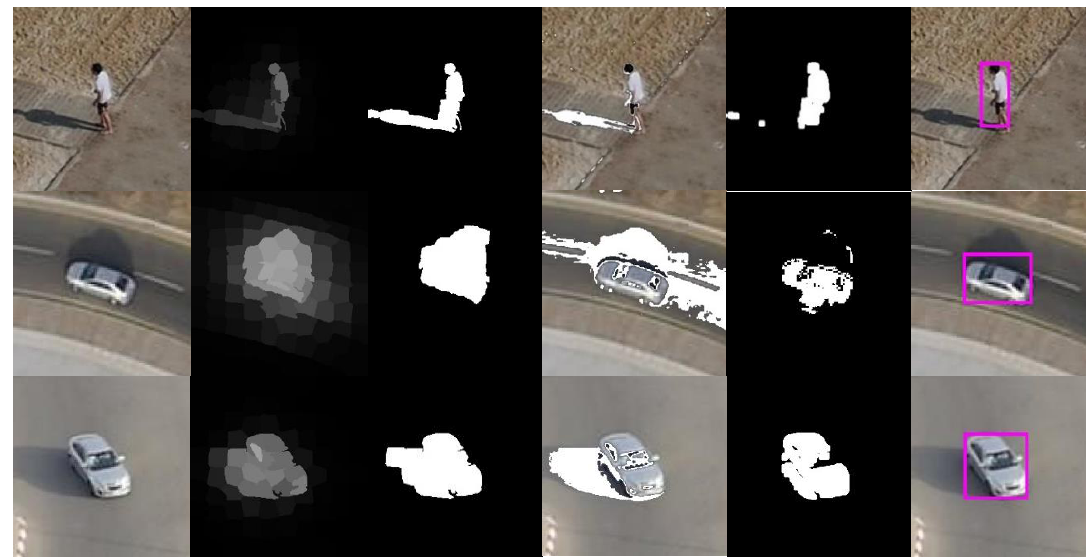
Figure 2. There are original images in the first column, saliency map in the second, binary saliency maps in the third, object shadows, detected on the image in the fourth column, binary image without shadow in the fifths and bounding boxes in sixths.